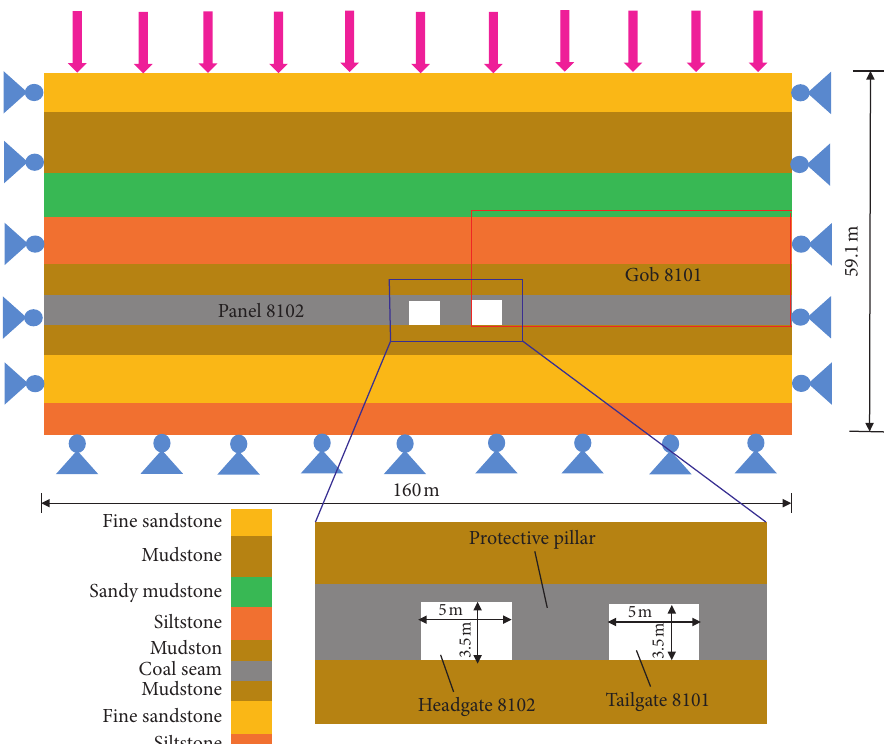
Figure 9: Numerical simulation